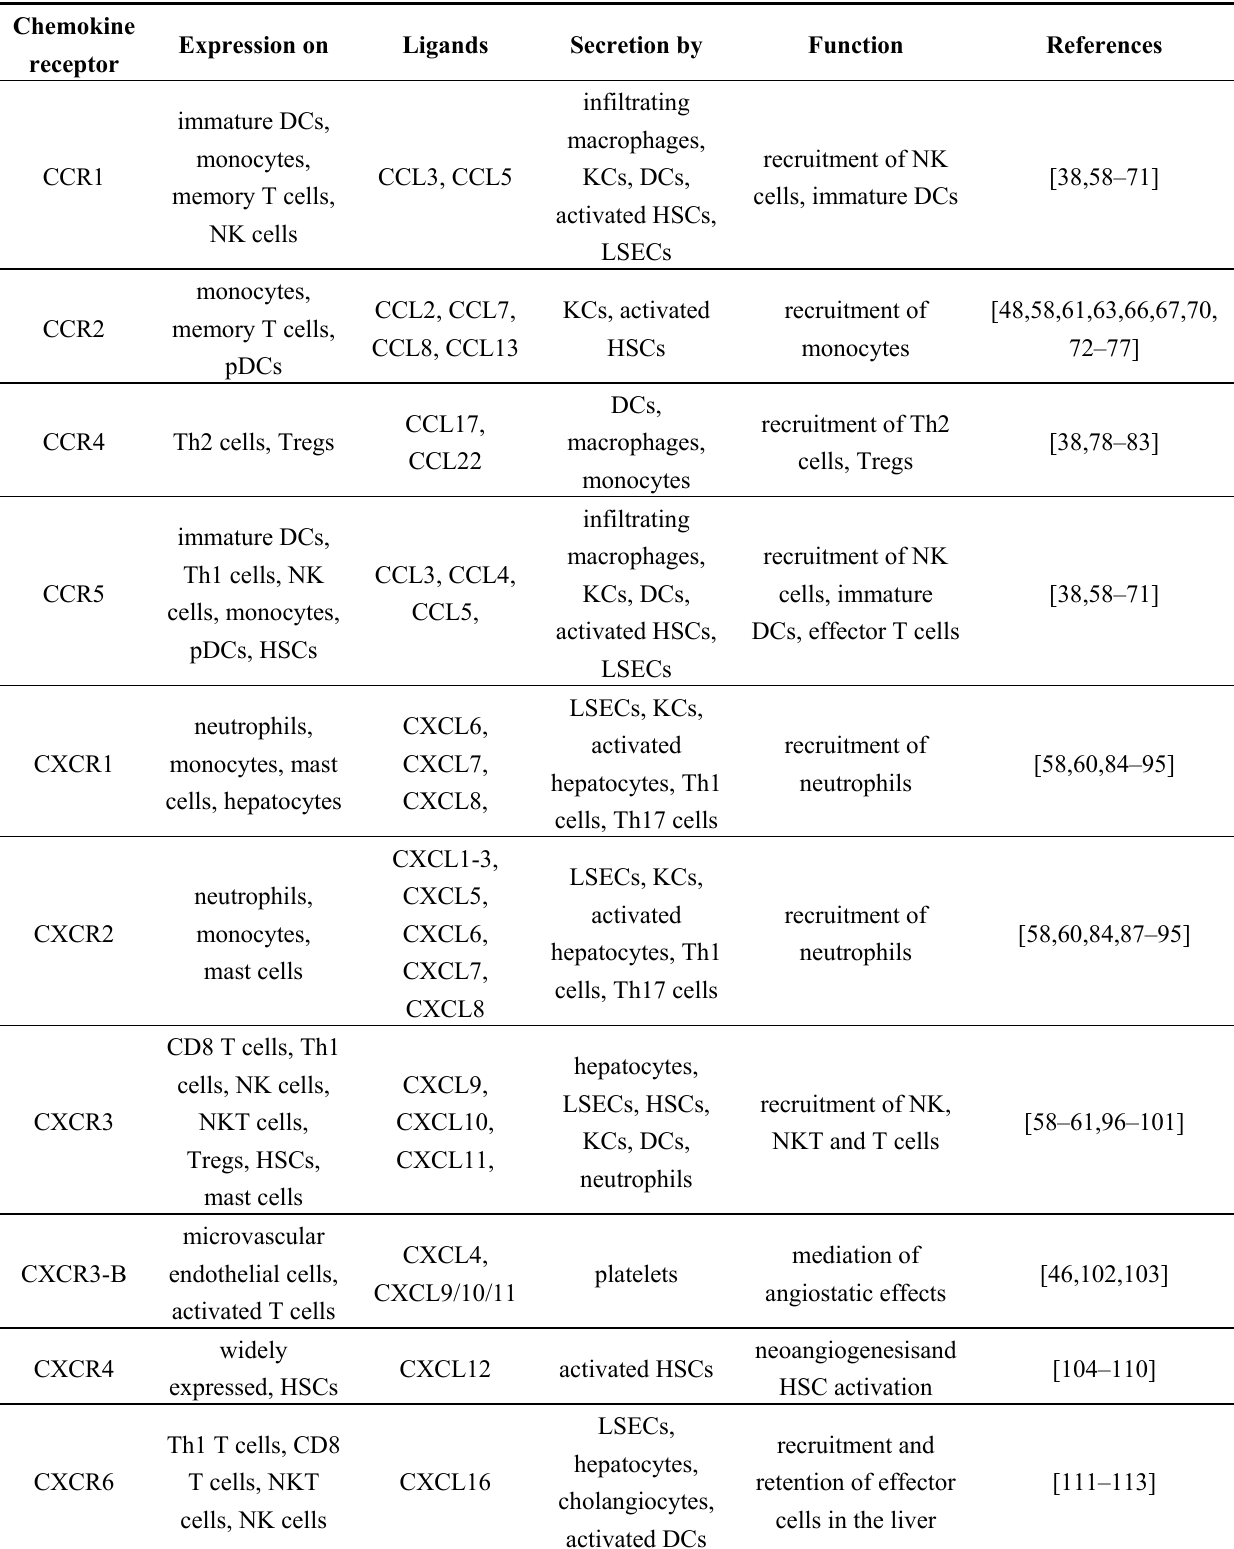
Table 1. Summary of the chemokine receptors and their ligands important in intra-hepatic immunity. Chemokine Expression on Ligands Secretion by receptor